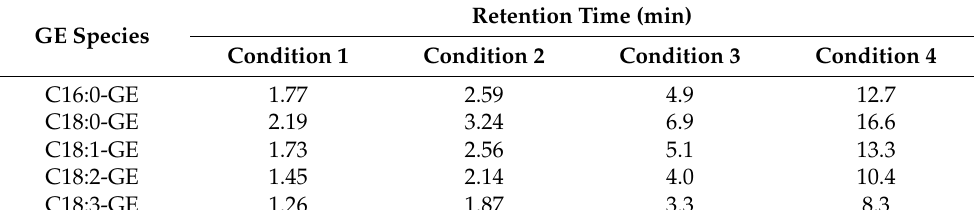
Figure 1. Chemical structures of five glycidyl ester (GE) species.